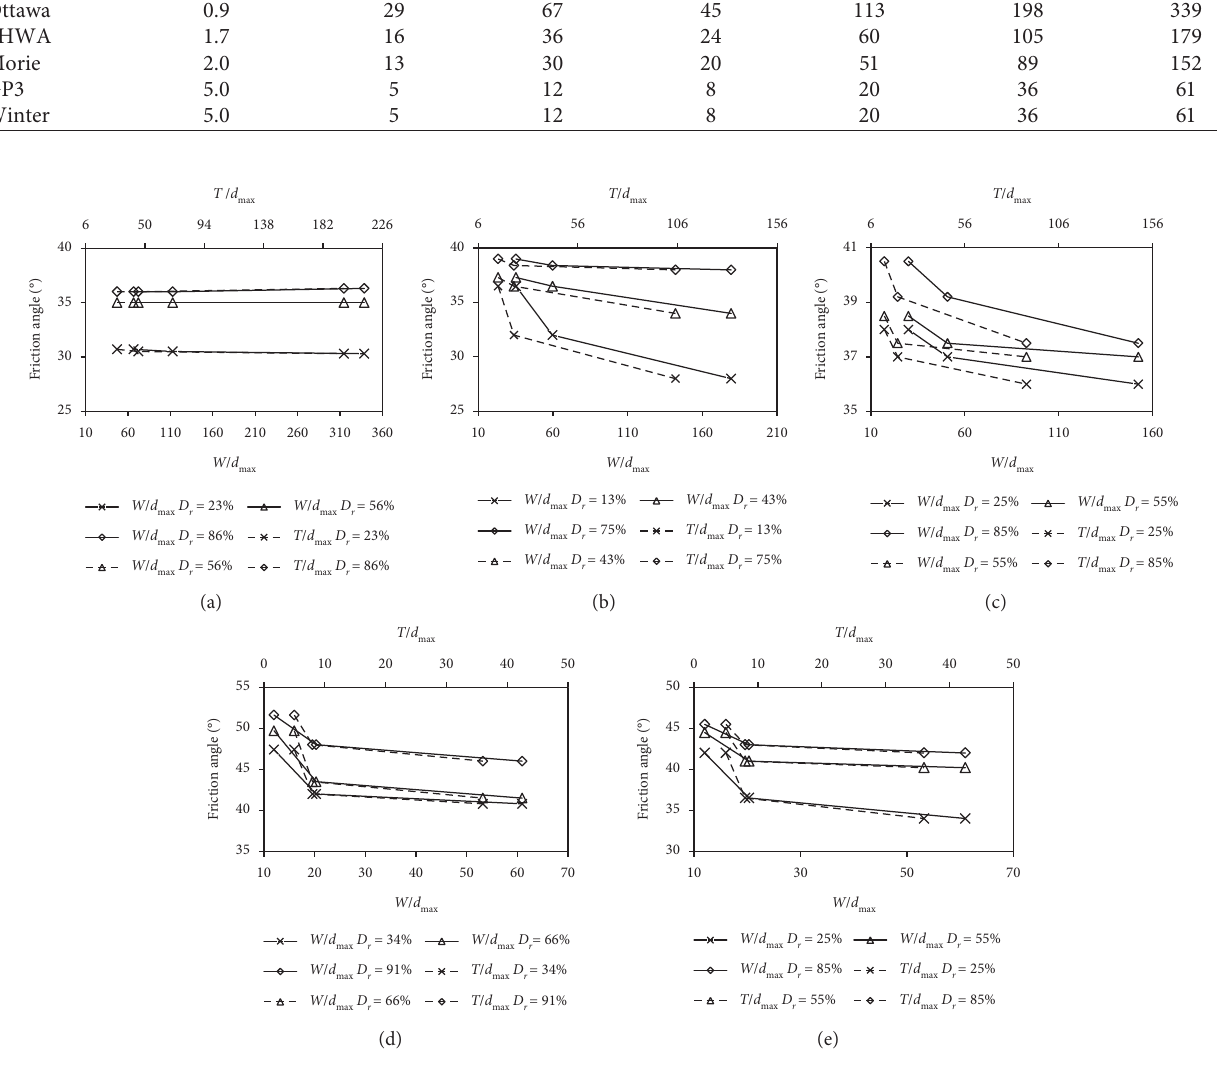
max ratios for specimens with different relative